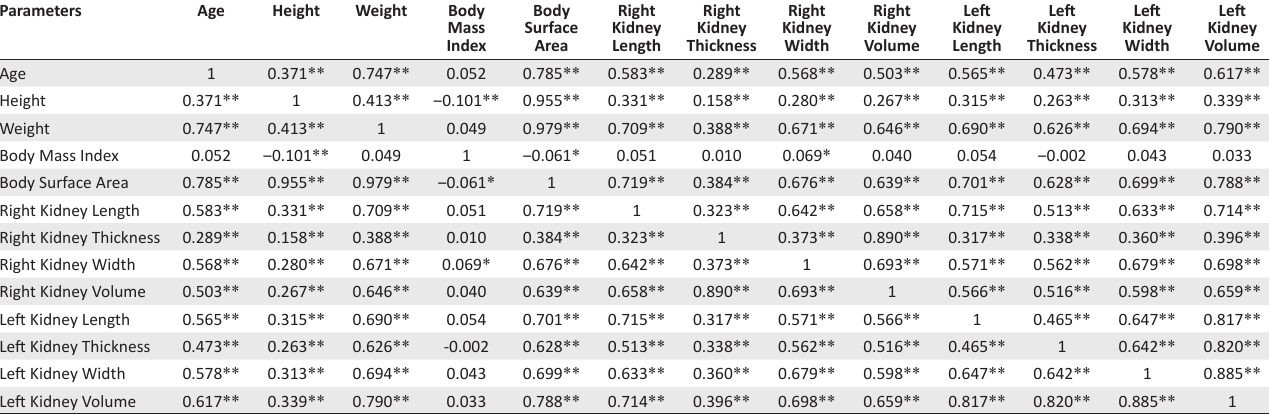
TABLE 4: Correlation matrix coefficients of renal dimensions with age and body size indicators. Parameters